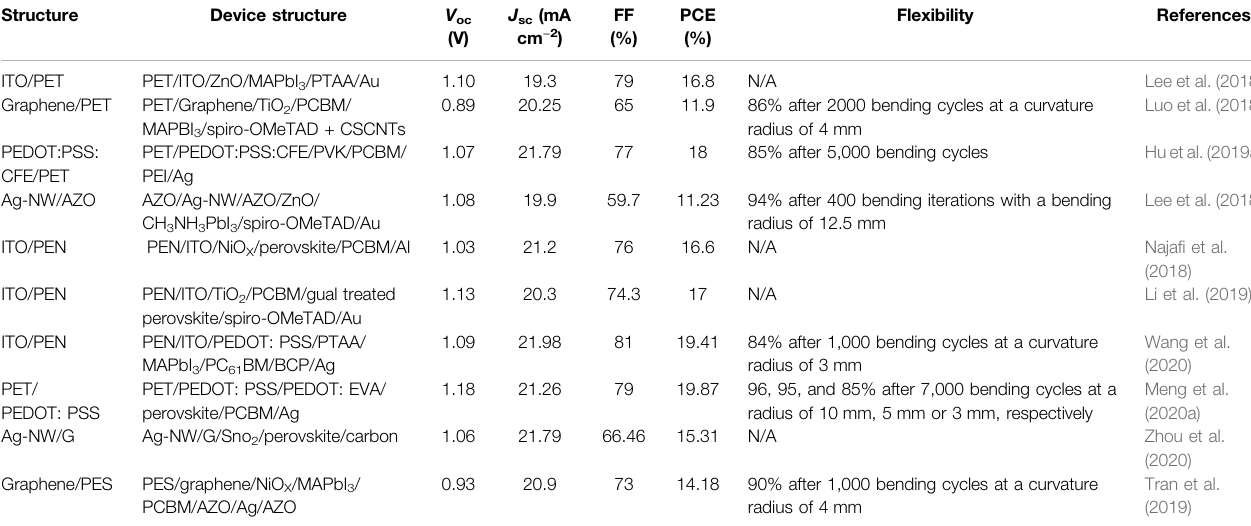
TABLE 1 | Summary of the photovoltaic and fl exibility performance of FPSCs fabricated on plastic/electrode substrates. Structure Device